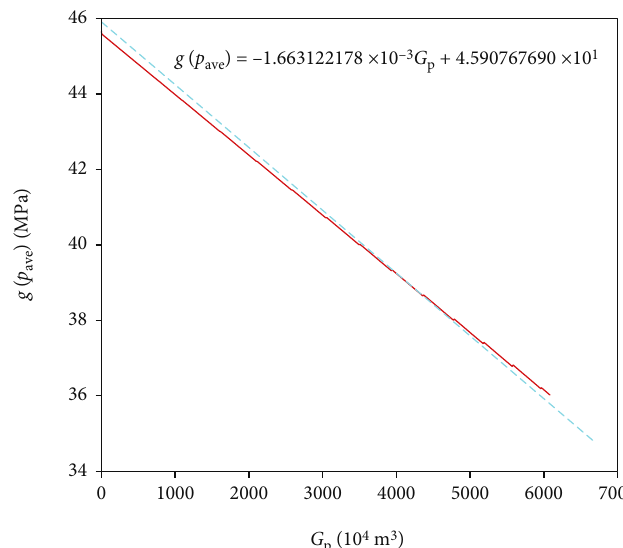
Figure 16: The relation of g ð p